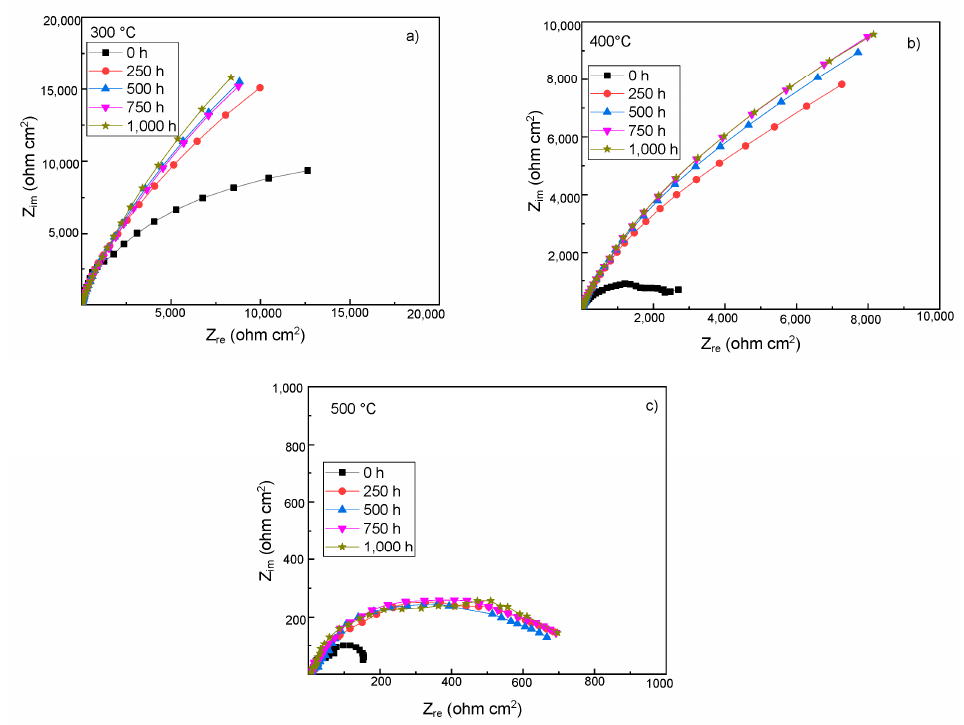
Figure 5. Nyquist diagrams for T91 steel in 60 wt% NaNO 3 -40%KNO 3 at ( a ) 300, ( b ) 400 and ( c ) 500 °C.